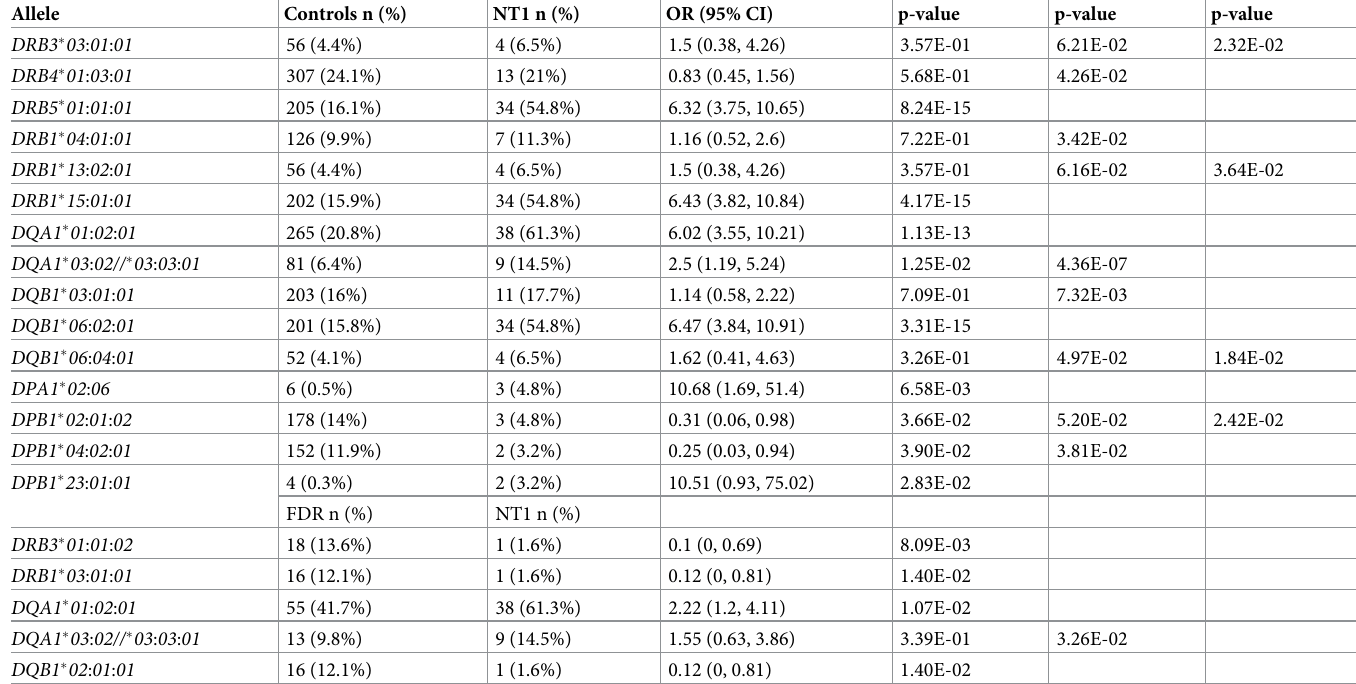
Table 1. RPE analysis of HLA-DRB3 , DRB4 , DRB5 , DRB1 , DQA1 , DQB1 , DPA1 , and DPB1 allele frequencies among NT1 patients (n = 31), population controls (n = 636) and first-degree relatives (FDR, n = 66).